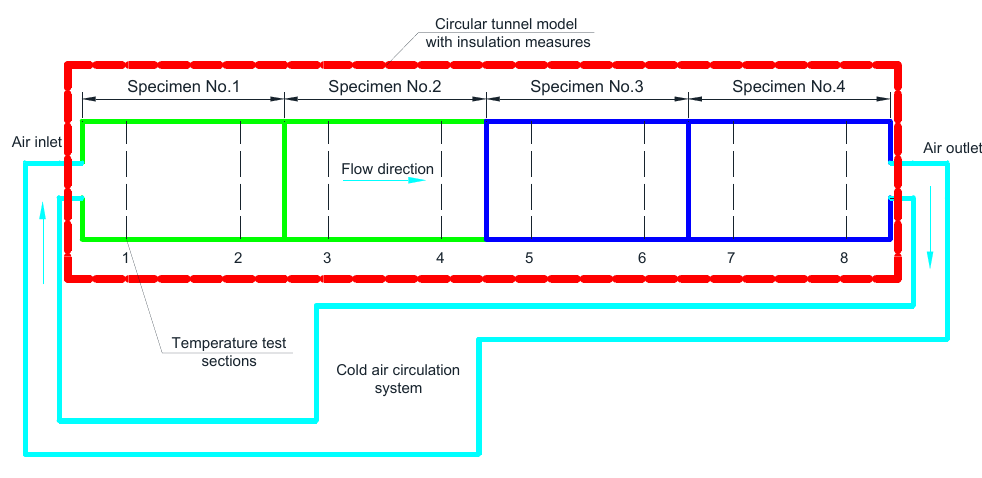
Figure 6. The experiment system.